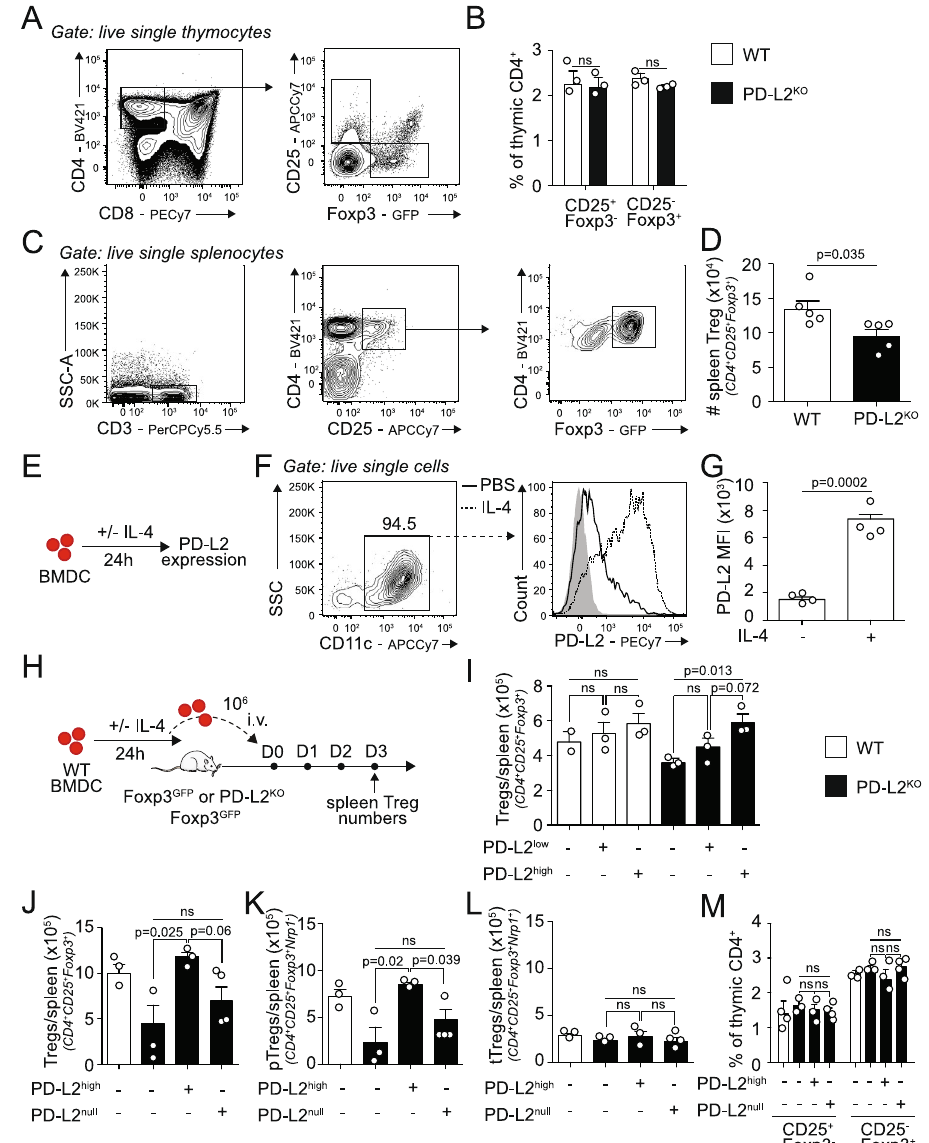
Fig. 3 | PD-L2 controls Treg homeostasis. A Thymus of Foxp3 GFP and PD-L2 KO Foxp3 GFP micewerecollectedandanalyzedby fl owcytometry.Representativeplots ofCD25 + (CD25 + TregPcells)andFoxp3 lo Tregcellprogenitors(Foxp3 lo TregPcells) analyzed based on CD25 and Foxp3 GFP expression. B Corresponding quantitation presented as mean±SEM. n =3 biologically independent mice. C Spleens of Foxp3 GFP andPD-L2 KO Foxp3 GFP micewerecollectedandanalyzedby fl owcytometry. Representative plots of CD3 + CD4 + CD25 + Foxp3 GFP+ total Tregs. D Numbers of total Tregs in WT and PD-L2 KO mice presented as mean±SEM. n =5 biologically inde- pendent mice. E BALB/c (WT) BMDC were differentiated in vitro for 7 – 10